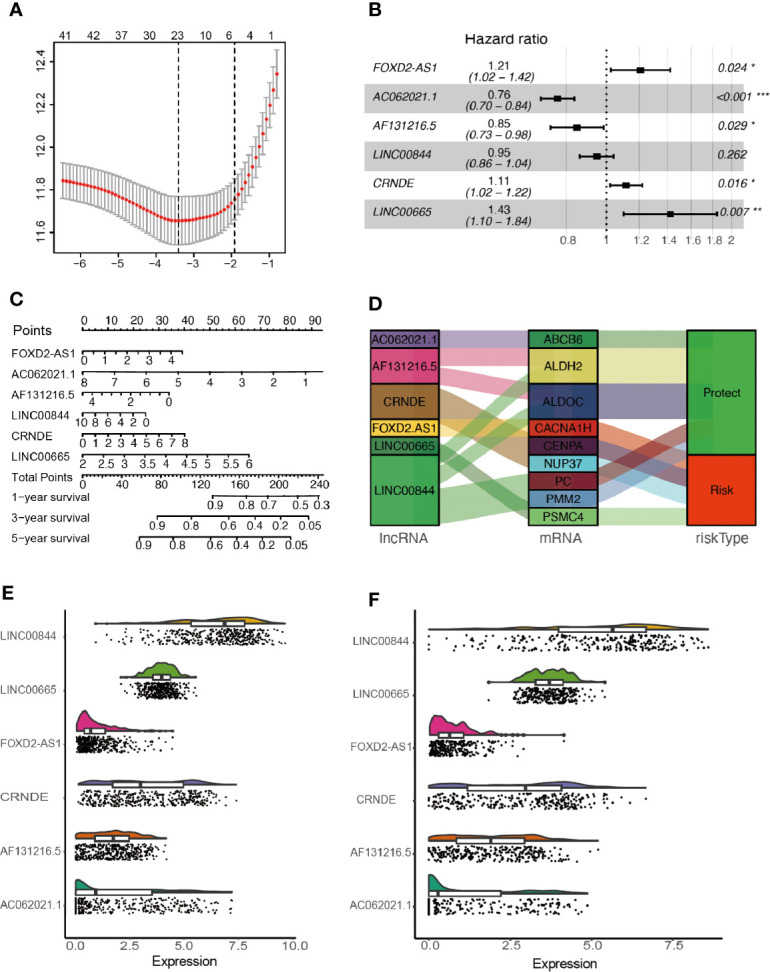
Network construction of the co-expressed and identification of key LncRNAs. (A) Texture feature selection using the LASSO regression model, λ value was chosen (1-SE criteria) according to cross-validation, where optimal λ resulted in six non-zero coefficients in the training cohort. (B) Construction of a risk signature to predict glioma prognosis by multivariate Cox regression. (C) Nomogram to predict the 1-, 3-, 5-year OS. (D) Sankey diagrams depicting the relationship of glycolysis-related protein-coding genes and glycolysis-related LncRNAs. (E, F) Expression of identified glycolysis-related LncRNAs in the training and validation cohorts. *P < 0.05, **P < 0.01, and ***P < 0.001.